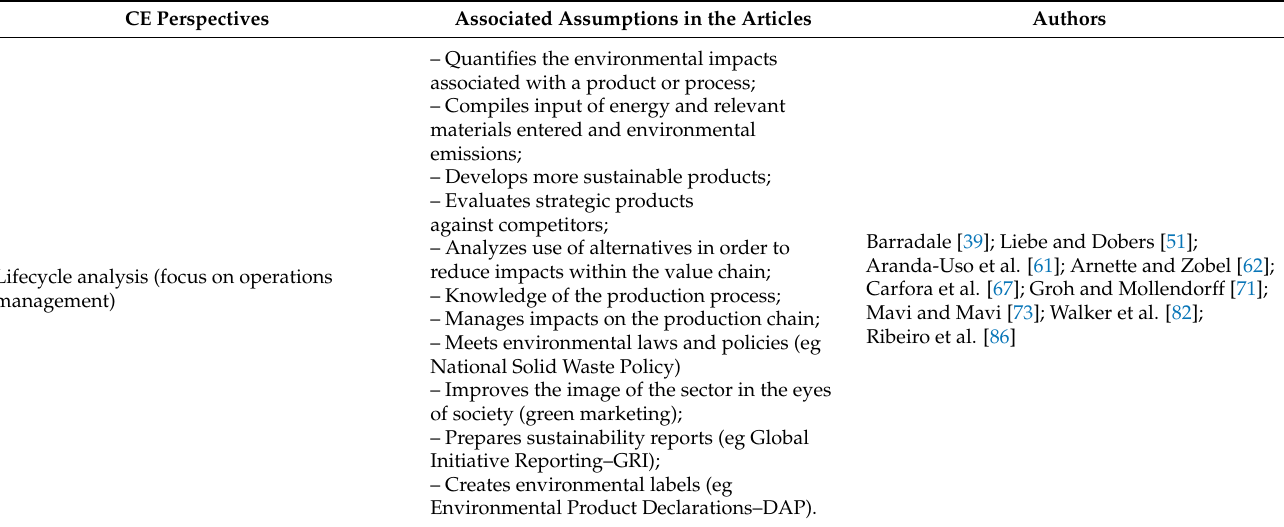
Table 7. Classification of CE perspective-associated assumptions found in SLR